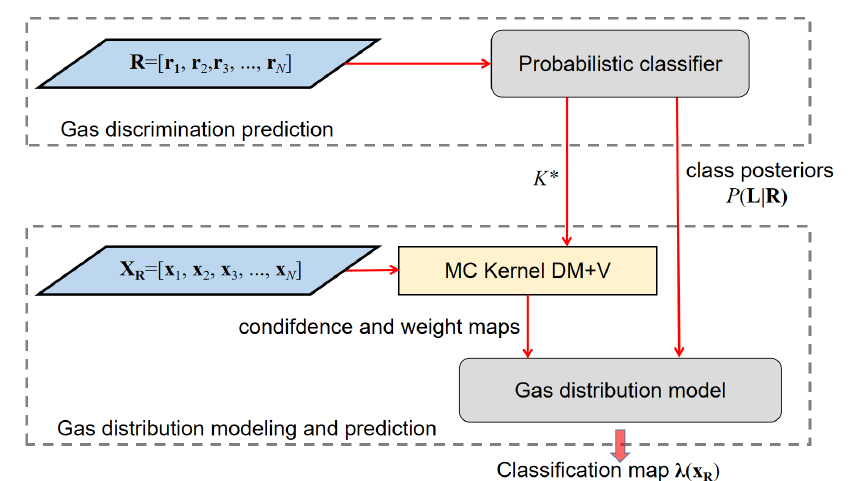
Figure 7. The gas distribution mapping module coupled with the class posteriors from the gas discrimination